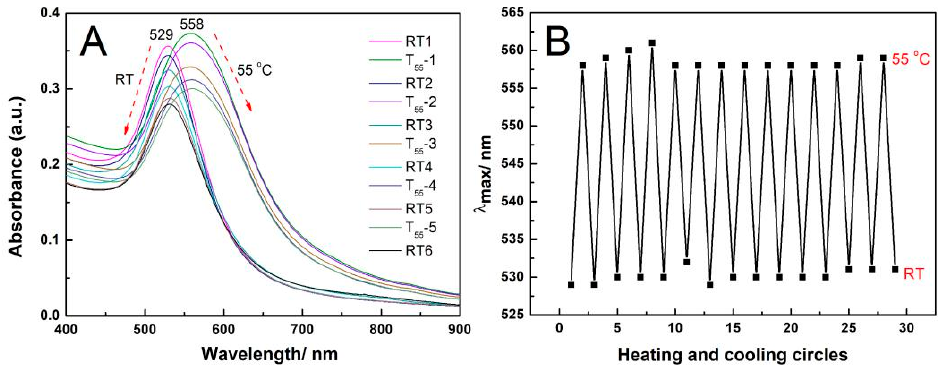
Figure 9. The change in Uv-vis spectra of Au-PNIPAM in the presence of 0.018 M HCl with heating-and-cooling cycles ( A ), and change of λ max with heating-and-cooling cycles ( B ).